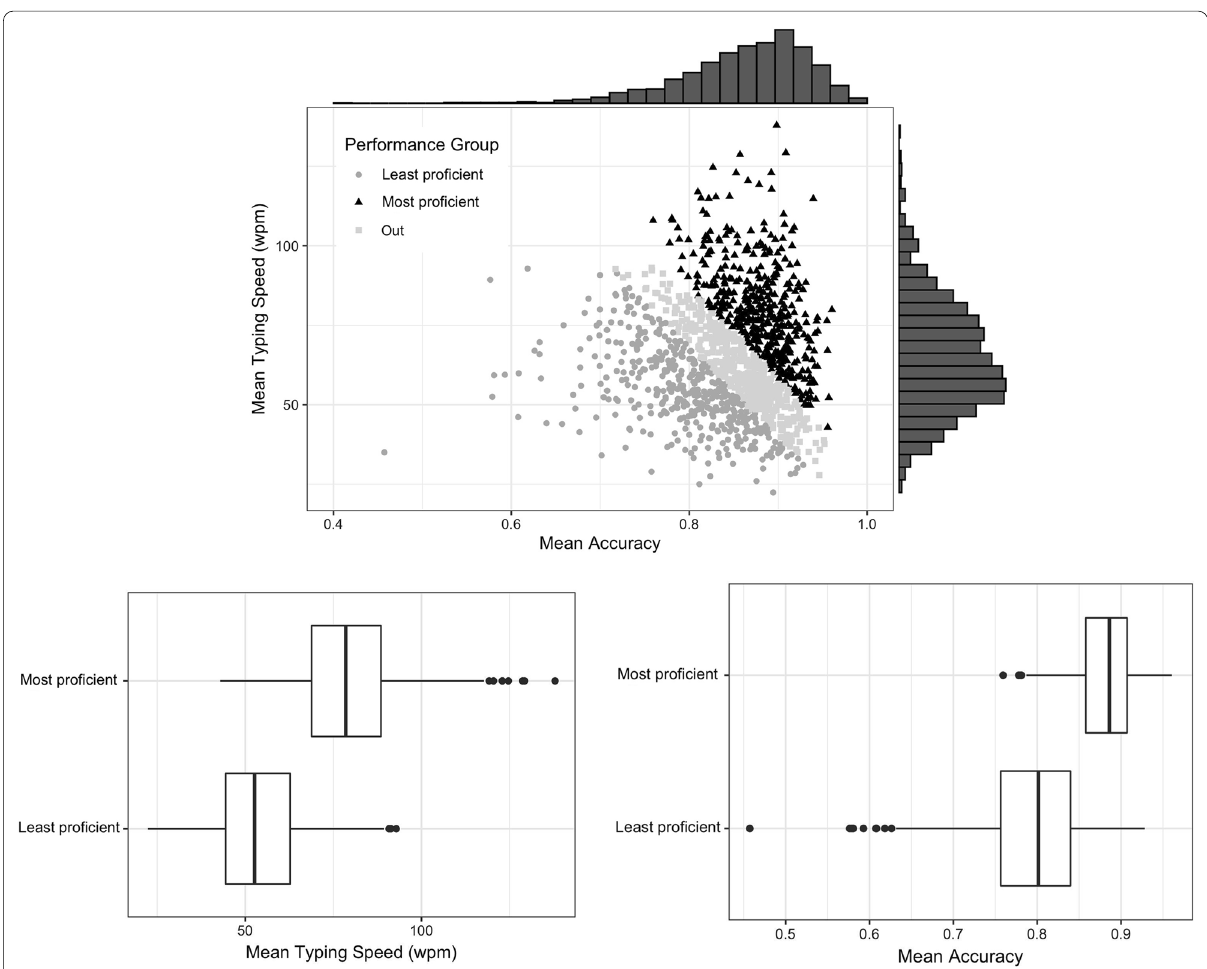
Fig. 4 Distribution of performance in the sample. Top: summary of performance in the sentence copying task on which the definition of performance groups is based. Mean typing speed (wpm: words per minute) is plotted as a function of mean accuracy (proportion correct). Each dot is a participant. Performance groups defined following the preregistered procedure are displayed in colour/shape. Marginal distributions of typing speed and accuracy are shown on the X and Y axes. Bottom: boxplots of the typing speed and accuracy rates of the two performance